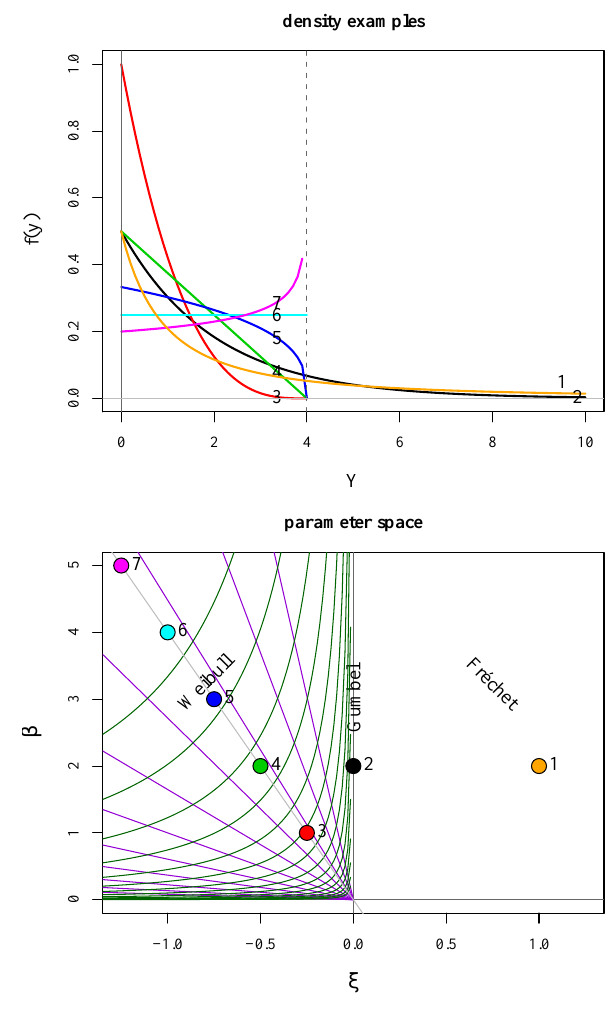
Fig. 1. Examples of GPD densities (upper diagram) covering all do- mains of attraction, and their representation in the parameter space (lower diagram), numbered correspondingly. This lower diagram shows the classical parametrization, the domains of attraction, and the proposed reparametrization: the rays are iso- µ lines (increasing µ values clockwise), and the hyperbolas are iso- ν lines (increasing ν values upwards; thus Gumbel domain corresponds to ν →−∞ ).